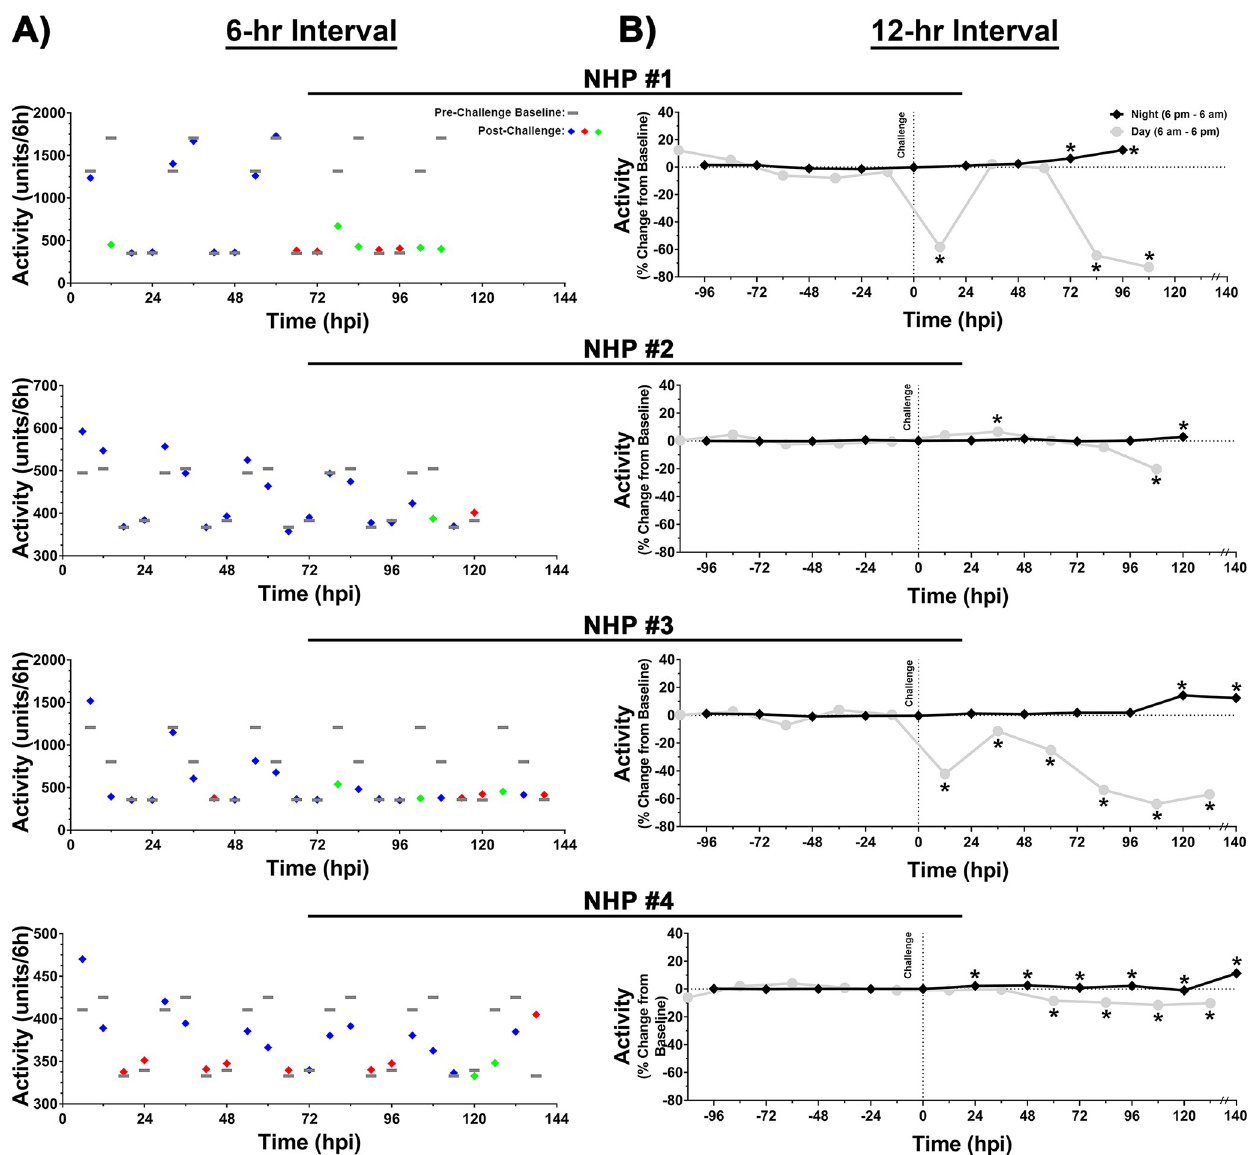
Fig 6. Measurement of activity in NHPs pre- and post-EEEV challenge. Data analysis is shown in 6- (A) and 12-hr (B) daytime/nighttime intervals. All NHPs were continuously monitored pre- and post-challenge. Pre-challenge baseline activity was measured for five day/night cycles and a 6-hr interval baseline average was calculated by averaging raw data of five time-matched day or night time intervals. Four 6-hr interval averages were used to construct a baseline activity for a day/night cycle and is shown as a grey line (A). Post-challenge values within � 3 standard deviations (SD) are indicated with ( ), > 3 SD above baseline are indicated with ( ), and > 3 SD below baseline are indicated with ( ). Percent change from baseline in 12-hr interval is shown in grey (daytime) and in black (nighttime) (B). All raw data from either 12-hr daytime or nighttime intervals were averaged and normalized. The last data point for NHP #3 and 4 is an average of 8 hrs (B). p -values � 0.041 are indicated with �